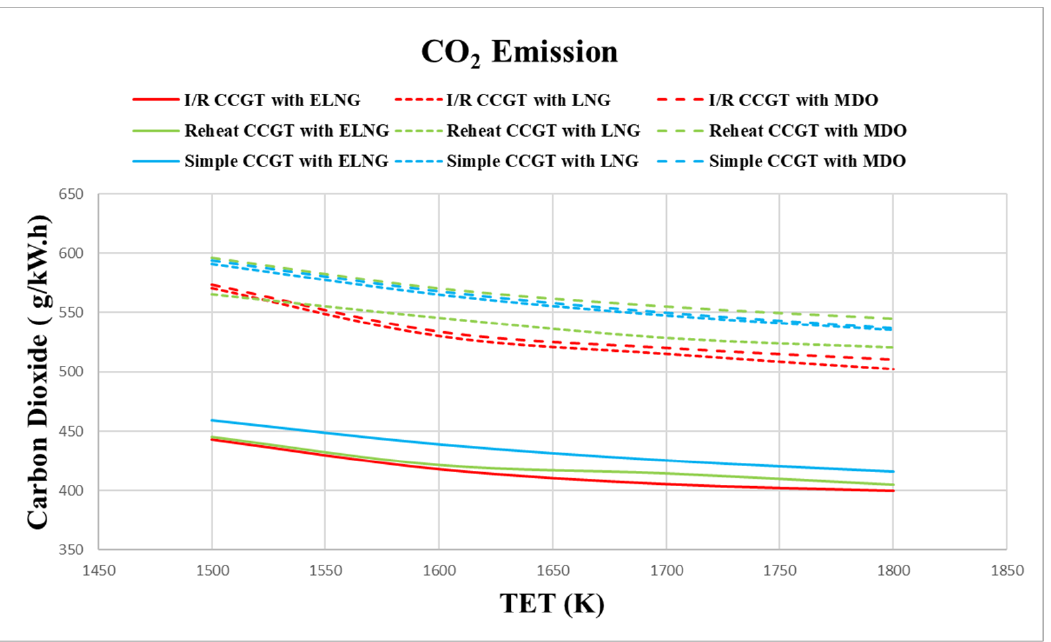
Figure 13. Effects of the TET on the CO 2 emissions.